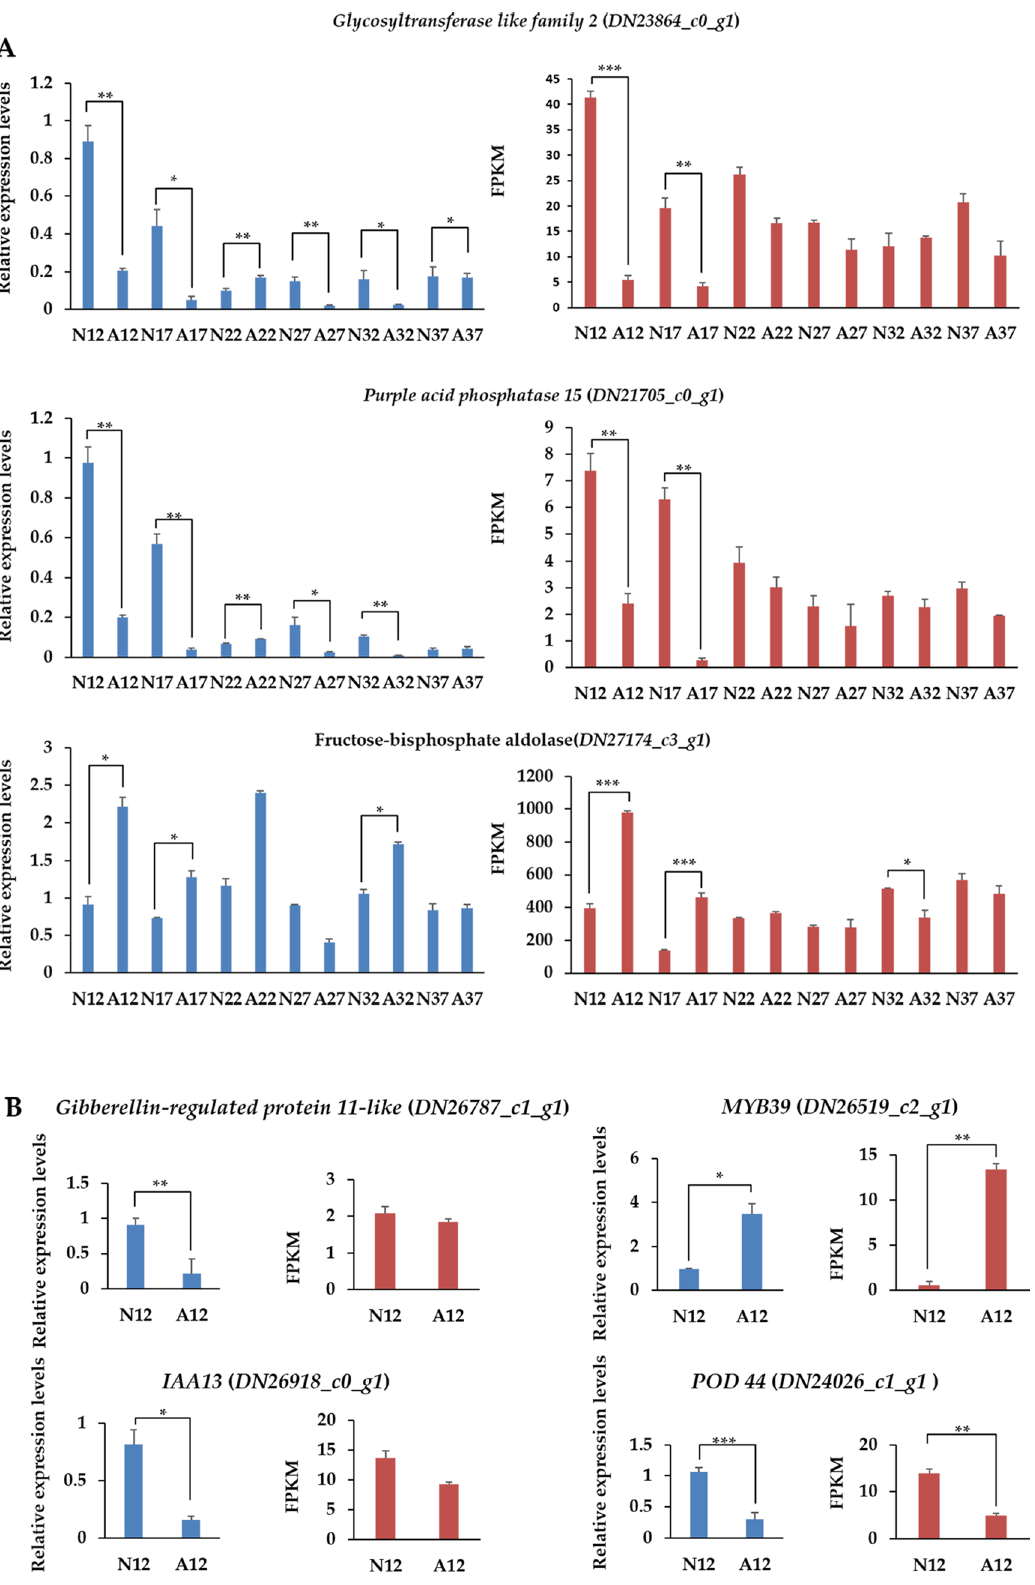
Figure 7. Relative expression analysis of six randomly selected DEGs related to almond fruitlet abnormally development. ( A ) Overall expression levels of glycosyltransferase like family 2 and purple acid phosphatase 15 across different developmental stages; ( B ) Expression levels of DEGs at specific stages. Bars give standard errors (n = 3). N normal, A abnormal. Blue, RT-qPCR analysis; red, RNA-seq analysis. P -values indicate statistical significance (* P < 0.05, ** P < 0.01, *** P <